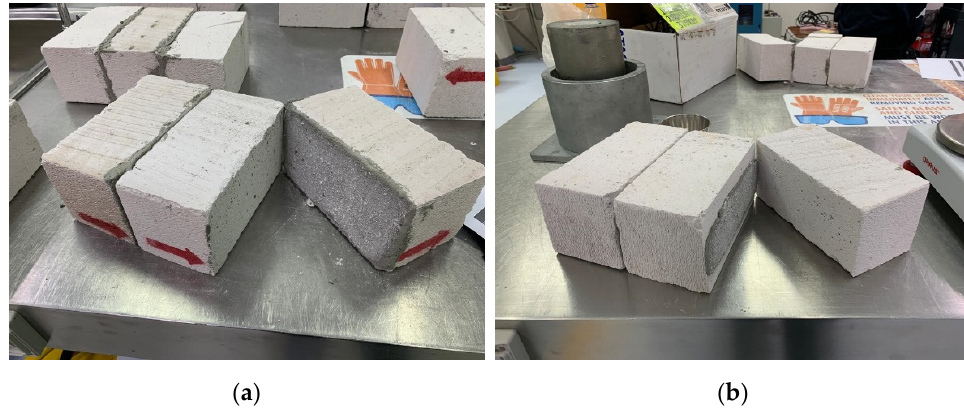
Figure 6. Shear bond failure of the tested block assemblies. ( a ) Fully grouted and ( b ) half-grouted.